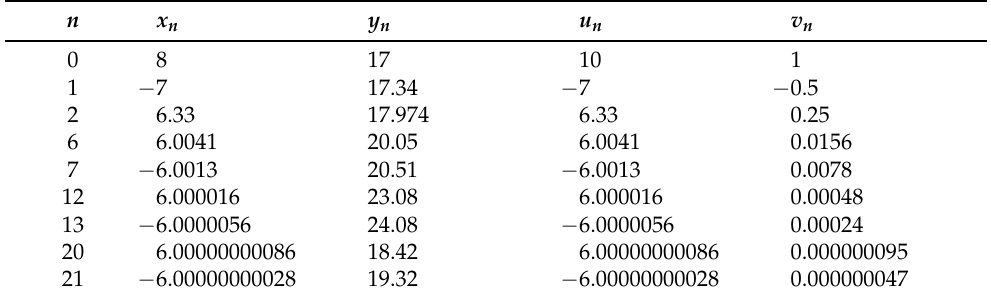
Table 1. Values of the iterated sequence ( x n , y n ) and ( u n , v n ) if started with ( 8,17 ) and ( 10,1 ) . n x n y n u n v